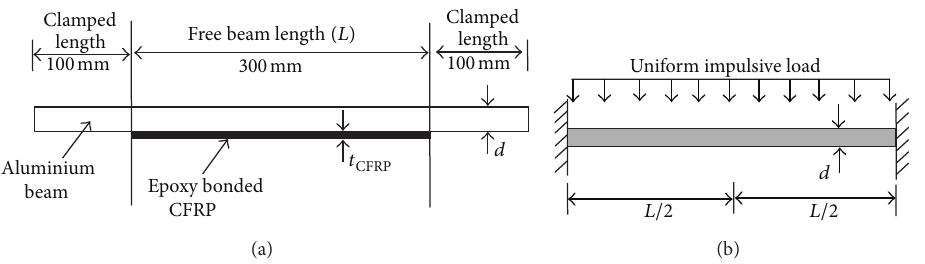
Figure 5: (a) A composite aluminum-CFRP beam specimen. (b) The idealized loading diagram [8].